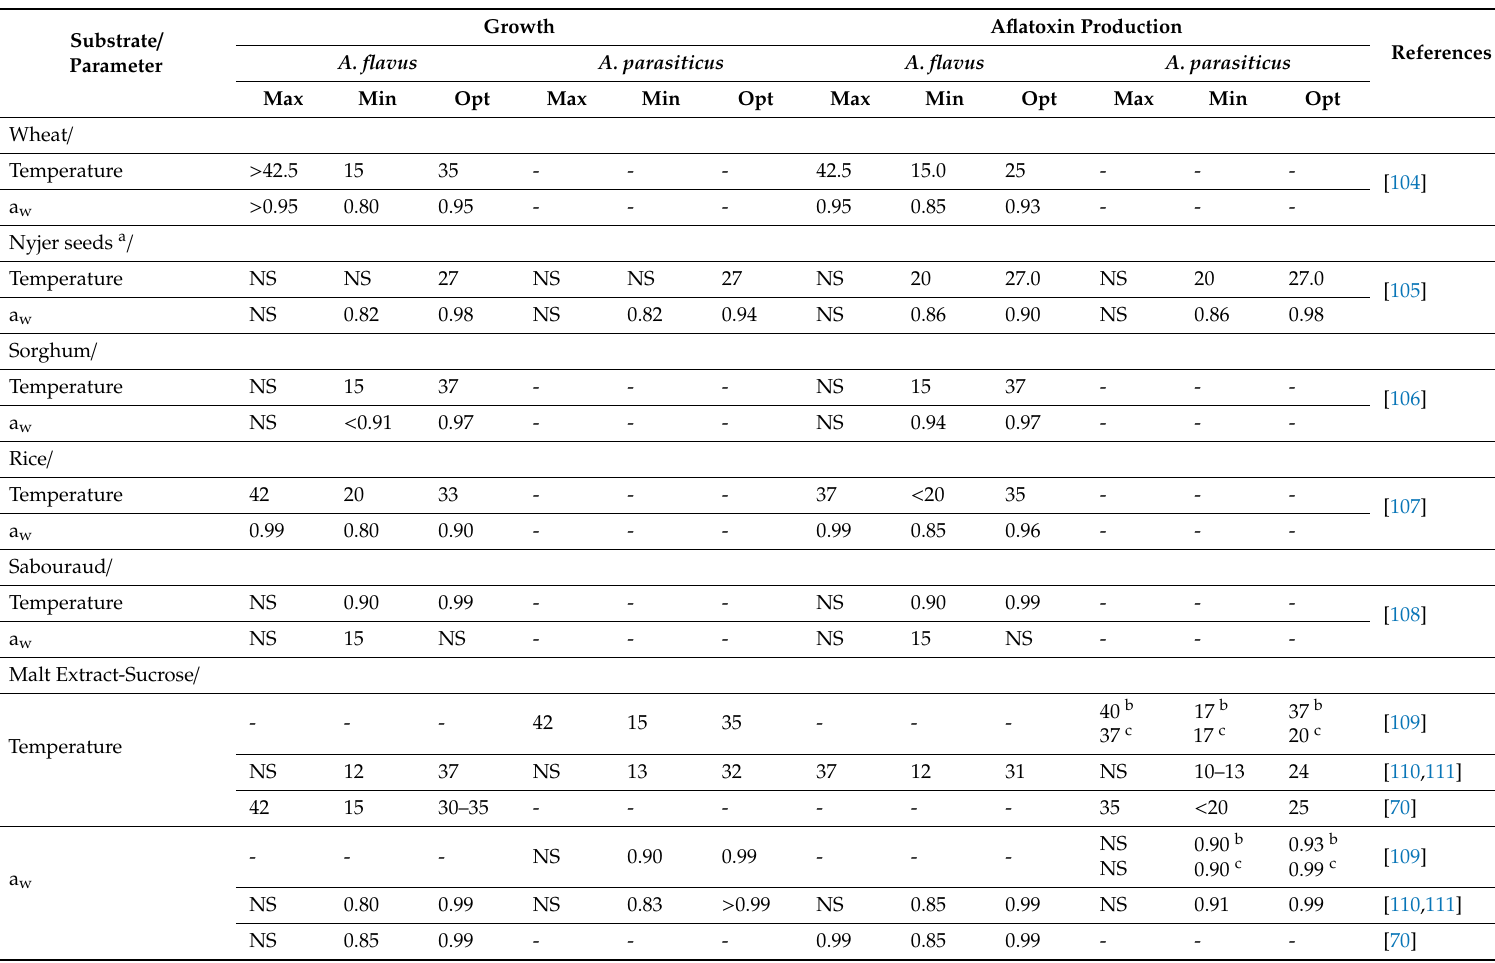
Table 4. Minimum (Min), maximum (Max) and optimum (Opt) values of Temperature ( ◦ C) and water activity (a w ) for the growth and aflatoxin production by Aspergillus flavus and Aspergillus parasiticus in selected grains and in laboratory